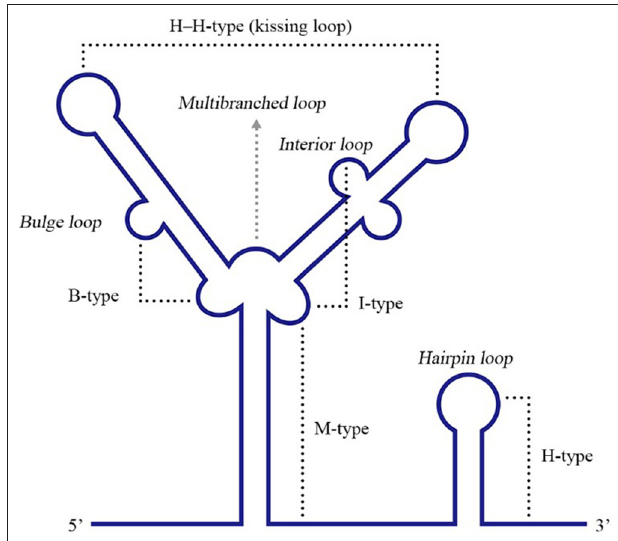
FIGURE 6 | Different types of RNA PK structures. Base pairing between a hairpin loop and a single-stranded region forms a H-type PK, while base paring between a multibranched loop and a single-stranded region forms an M-type PK. A bulge or interior loop together with a multibranched loop can form a B-type or I-type PK. Additionally, two hairpin loops form an H-H-type PK. Adapted from Brierley et al. (2007). This figure has been approved by